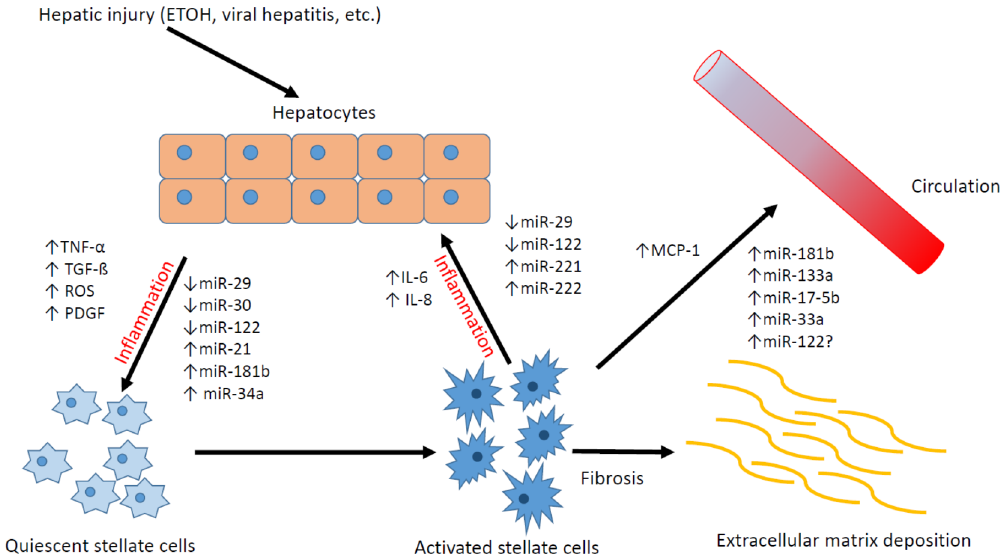
Figure 1: Relationship between hepatic stellate cells, hepatocytes, and microRNAs. Figure 1. Relationship between hepatic stellate cells, hepatocytes, and microRNAs.